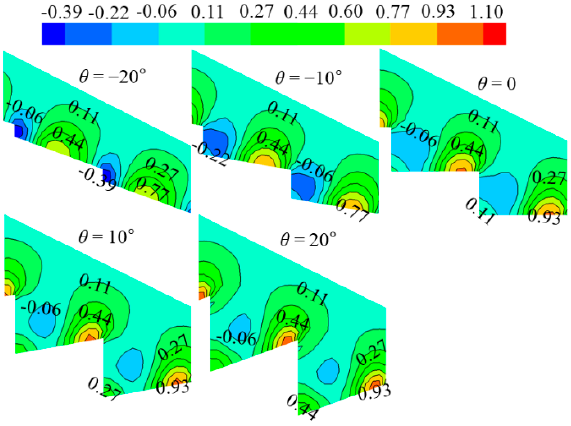
Figure 5. Pressure contours ( P / ρ gd c ) at different θ values at steps no. 42 and 43 ( d c /h = 4.8).